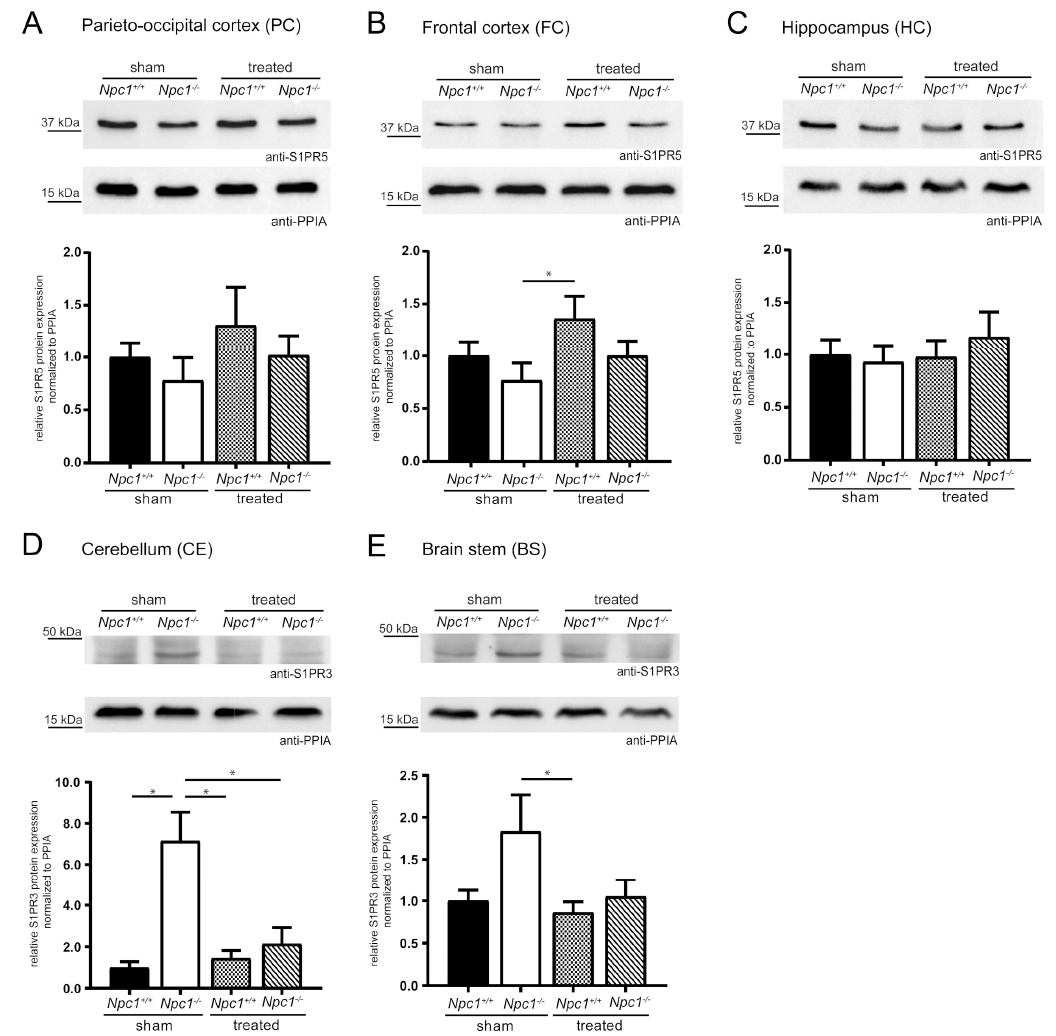
Figure 4. Semiquantitative western blot analyses of various brain regions from sham-treated and treated Npc1 +/+ and Npc1 -/- mice to detect S1PR3 and S1PR5. Membrane fractions of total protein lysates were probed with anti-S1PR3 (42 kDa) or anti-S1PR5 (42 kDa) antibody. S1PR5 protein expression was examined in PC ( A ), FC ( B ) and HC ( C ). PC and FC tended to reduced S1PR5 protein expression in sham-treated Npc1 -/- mice, compared to sham-treated Npc1 +/+ mice. This change tended to be prevented in treated Npc1 -/- mice. However, treated Npc1 +/+ mice showed a tendency of an increase compared to sham-treated Npc1 +/+ mice. In contrast, in the HC, weak changes of sham-treated Npc1 -/- mice could be observed. Nevertheless, treated Npc1 -/- mice showed increased S1PR5 protein expression compared to the respective sham-treated mice. The S1PR3 protein expression was examined in the CE ( D ) and BS ( E ). The CE showed a significant increase in sham-treated Npc1 -/- mice, compared to sham-treated Npc1 +/+ mice, which was prevented by the treatment, showing a significant reduction in treated Npc1 -/- mice compared to sham-treated Npc1 -/- mice. The BS showed the same changes as the CE. However, there was a small tendency of increased S1PR3 expression in sham-treated Npc1 -/- mice compared to sham-treated Npc1 +/+ mice, that tended to be prevented by treatment, showing a decrease of treated Npc1 -/- mice compared to sham-treated Npc1 -/- mice. Protein levels were quantified and normalized according to the levels of PPIA (18 kDa). Experiments were repeated with n = 4 to 5 biologic controls and N = 3 technical controls. Data represent the ratio of the mean ± SEM (sham-treated Npc1 +/+ set to 1). p ≤ 0.05 was considered to be significant (* p ≤ 0.05). Statistical analysis was performed using the two-tailed nonparametric Mann–Whitney U test.